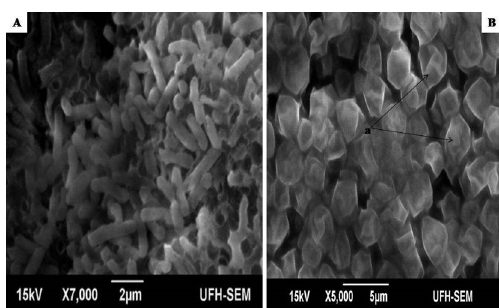
Fig. 2. Influence of ethanol extract on the morphology of S. flexneri . A = Extract untreated S. flexneri ; B = Extract treated S. flexneri . (a = polygon shaped, collapsed or squeezed cells).